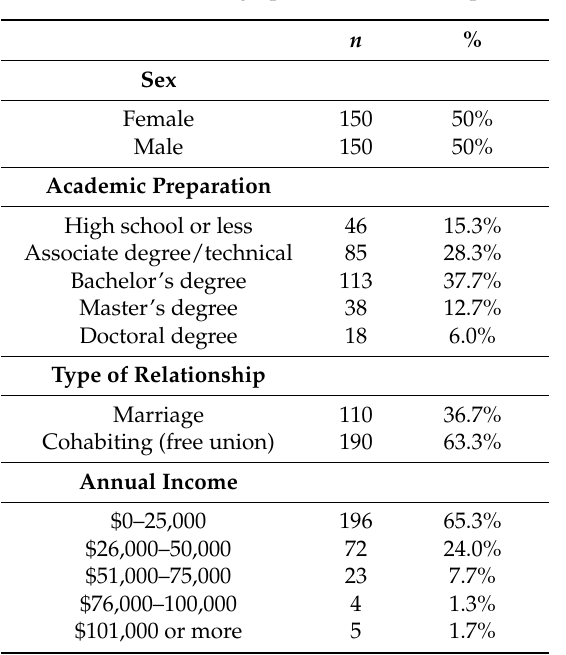
Table 1. Sociodemographic data of the